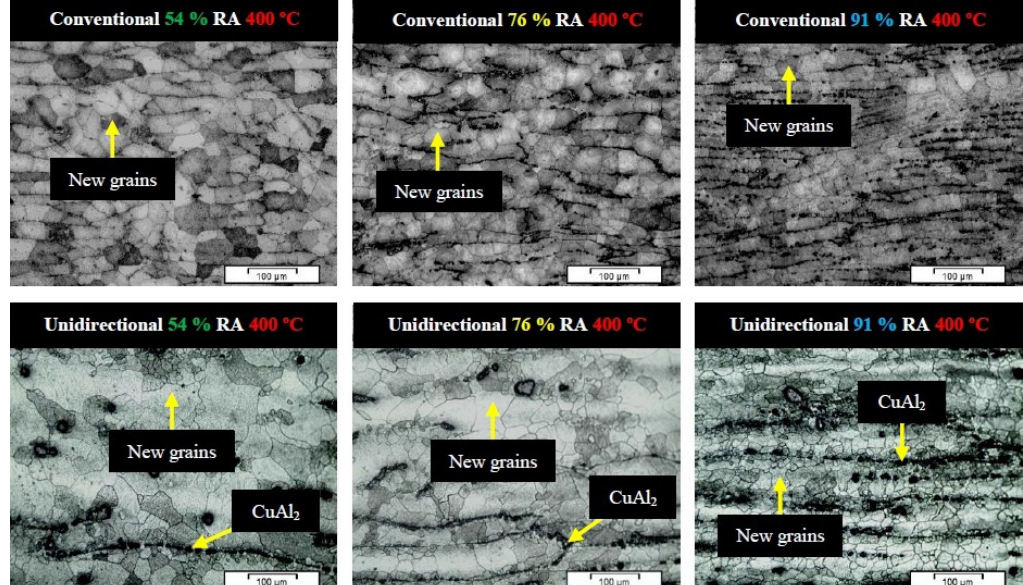
Figure 11. Micrographs of the Al4.5wt%Cu alloy conventionally and unidirectionally solidified after 54, 76 and 91% of RA and heat treatment of 400